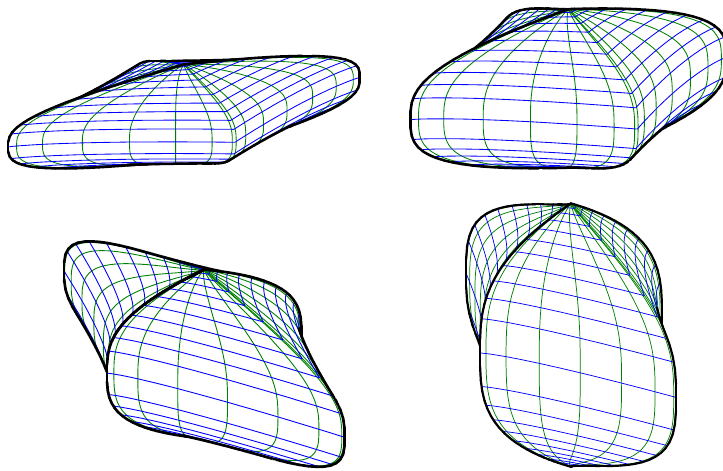
Figure 10. Entries on the diagonal of each diagonal matrix A are different.